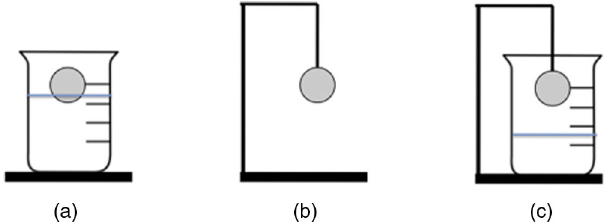
FIG. 5. Depiction of three balls in Ms. Clark ’ s instructional